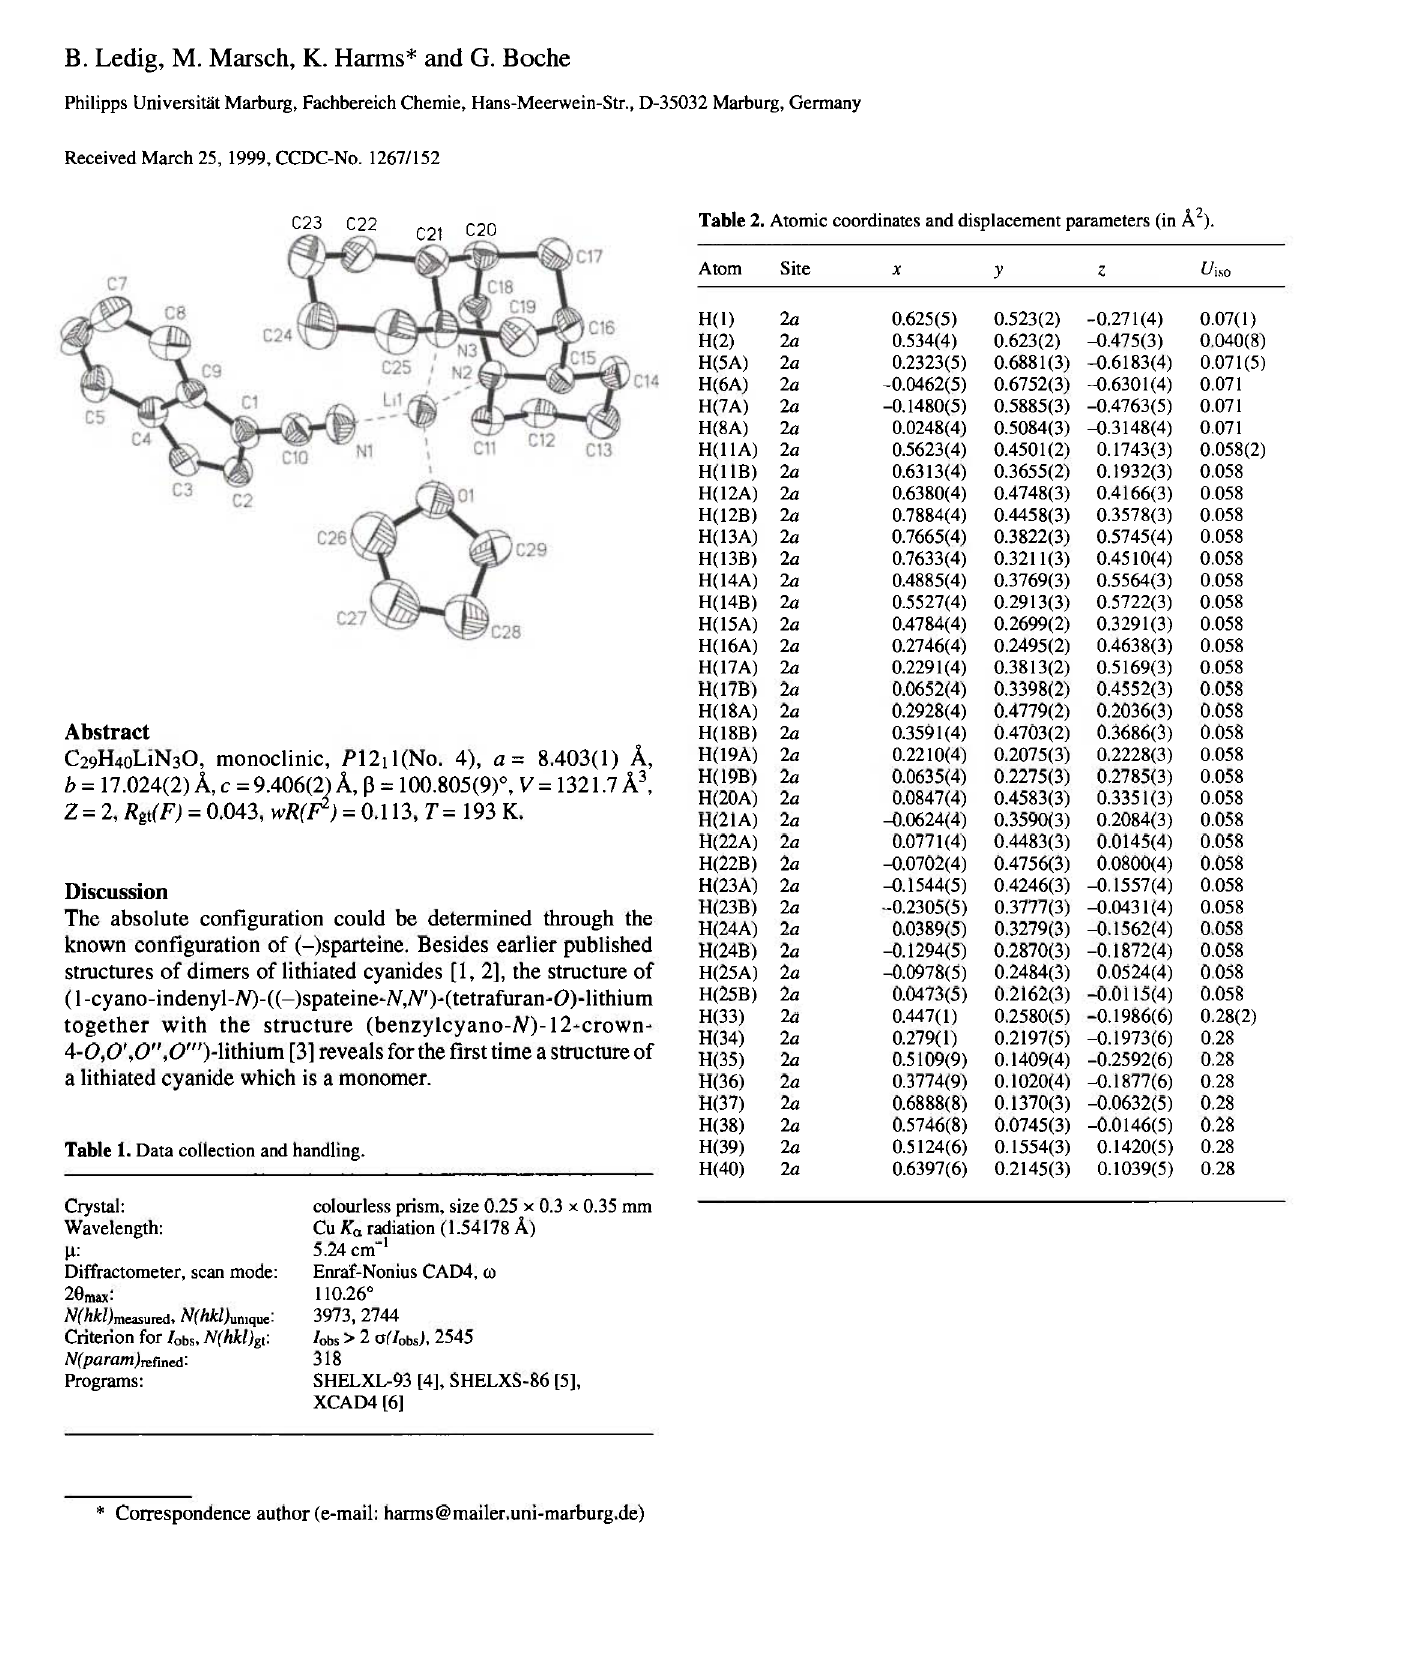
Table 2. Atomic coordinates and displacement parameters (in Ä 2